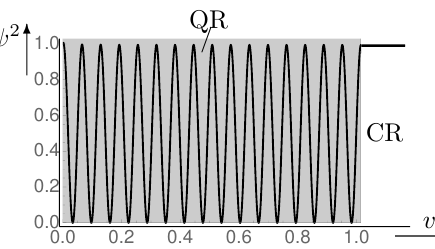
(cid:82) ψ ˆ p v ψ dv = 0 and substructures obtained by choosing QR